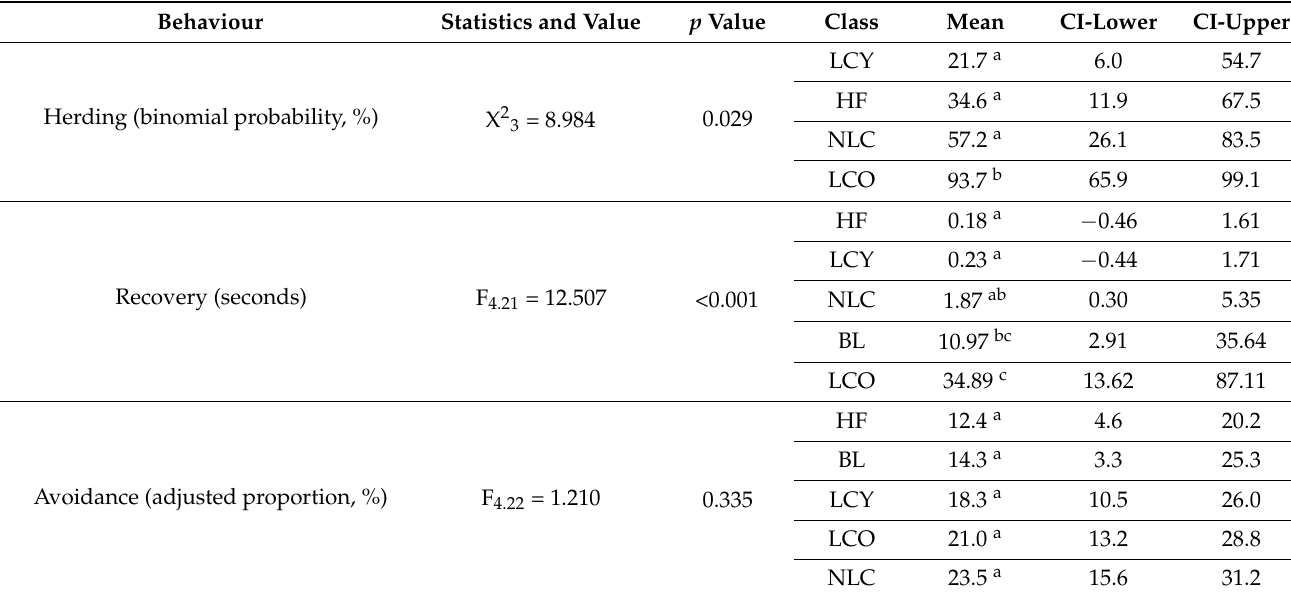
Effects of cattle classes (LCY = lactating cows with young calves less than three months old, LCO = lactating cows with old calves that were between eight and ten months old, NLC = non-lactating cows, HF = heifers, BL = bulls) on cattle behavioural reactions in Experiment 2. Within each behaviour, cattle classes followed by the same superscript are not significantly different, using Tukey’s test. Adjusted proportion = aggregated behaviour duration/(test duration × total number of animals in the test). All percentage (%) means are within a test